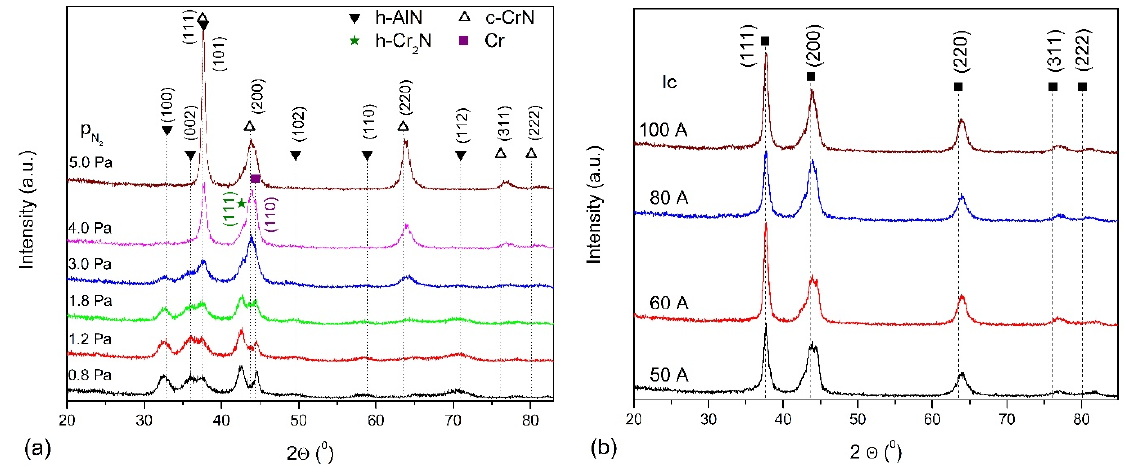
Figure 3. Diffraction patterns of AlCrN coatings formed at: ( a ) various nitrogen pressure, ( b ) various arc current. The coatings formed at different arc currents have a similar diffraction patterns, Figure 3b. The diffraction lines correspond to the major lines of the cubic CrN phase. (200)/(111) diffraction lines is 1.22, while for coatings formed at different arc currents ranges from 0.61 to 0.88. This shows that these coatings are strongly textured.